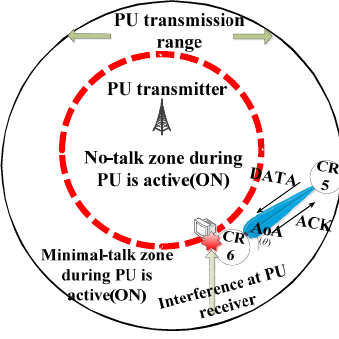
Figure 3. PU receiver interference due to CR spectrum